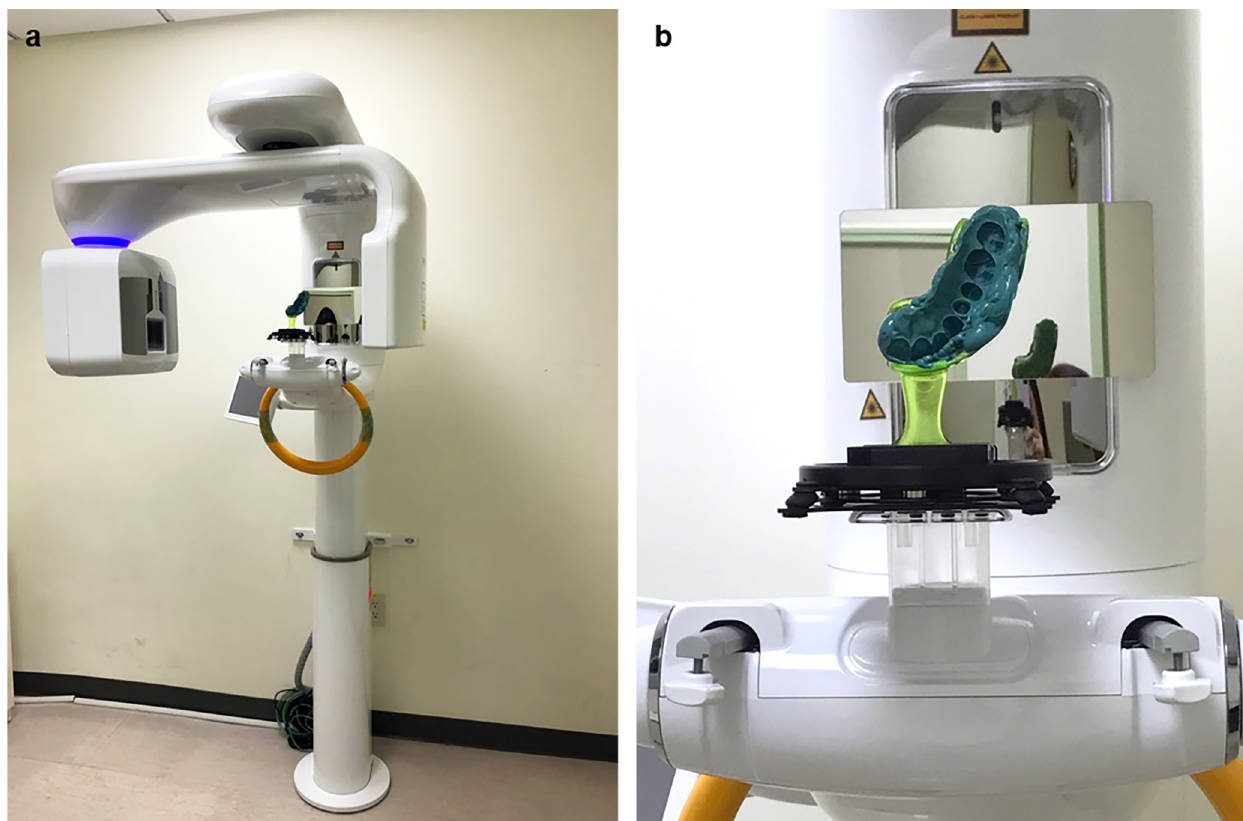
Fig 2. Cone-beam computed tomography (CBCT) scanning. (a) CBCT apparatus (RAYSCAN α +) and (b) a polyvinylsiloxane impression fixed on a customized chin rest provided by the manufacturer for scanning.